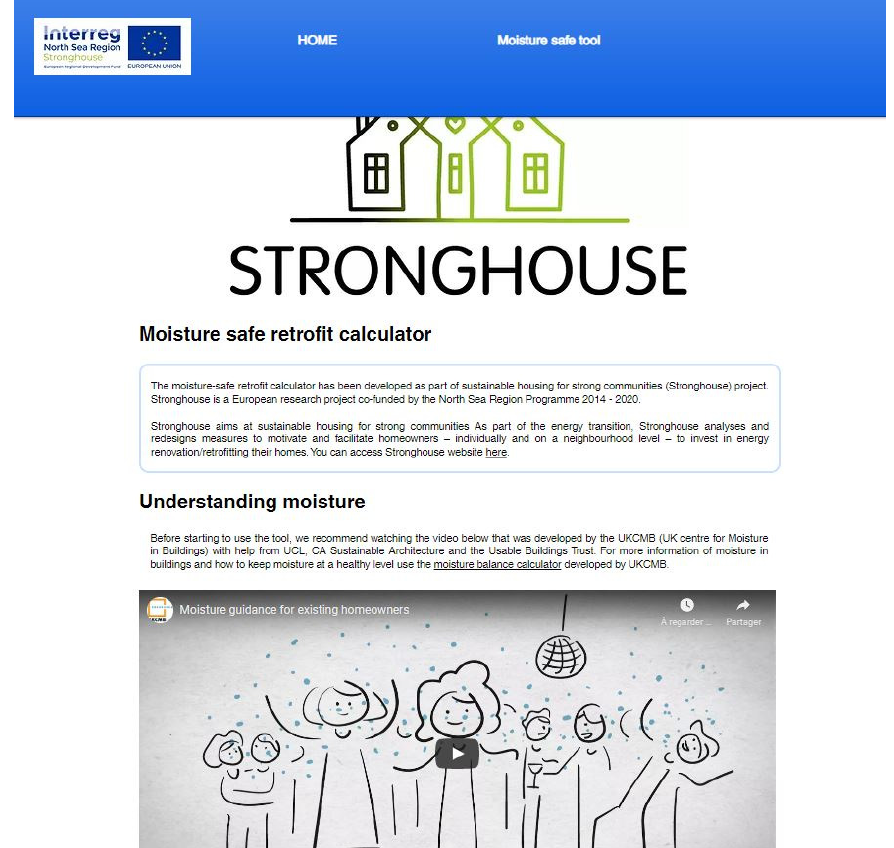
Figure 4. My home page.